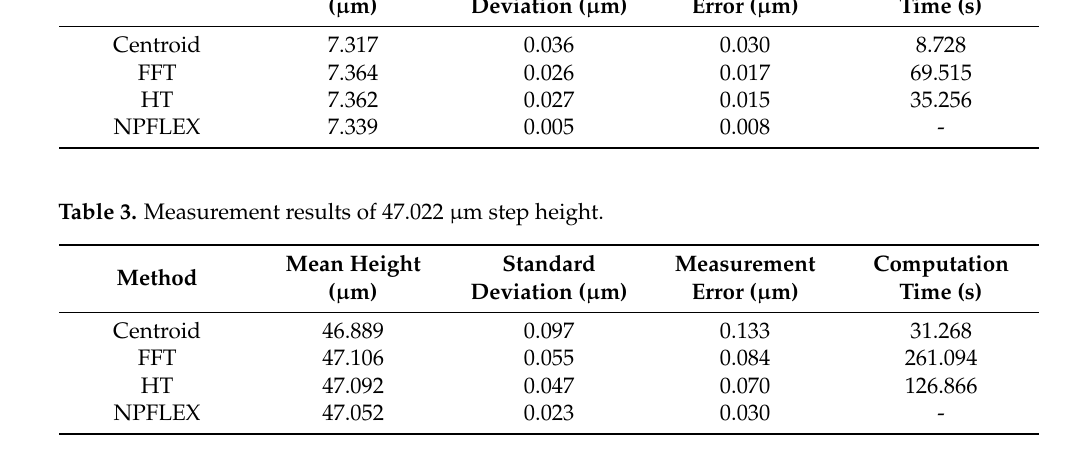
Table 3. Measurement results of 47.022 μ m step height.